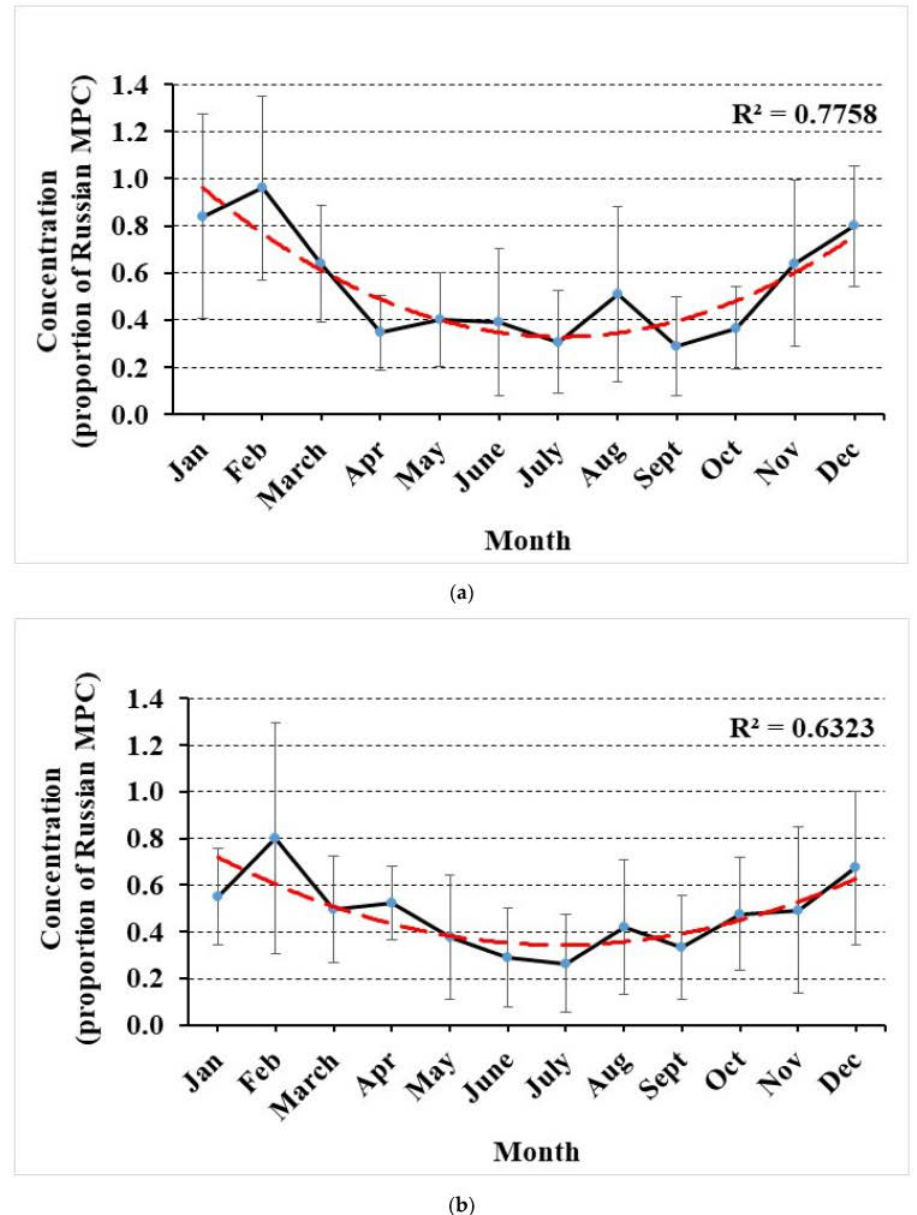
Figure 11. Intra-annual change in concentrations of PM 2.5 ( a ) and PM 10 ( b ), expressed in proportion of Russian Federation MPC (the red dotted line is the trend